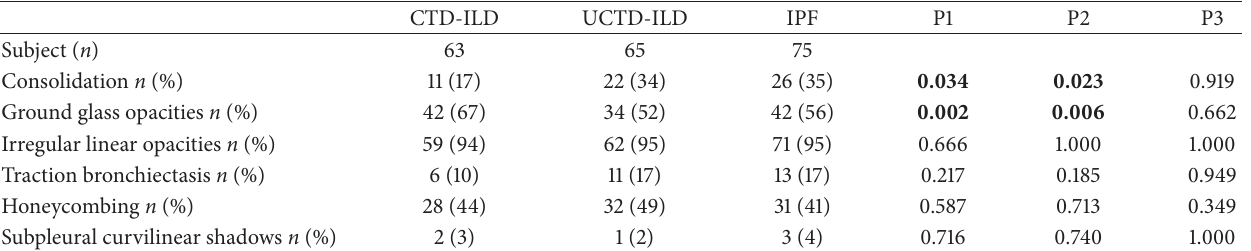
Table 5: HRCT findings of ILD